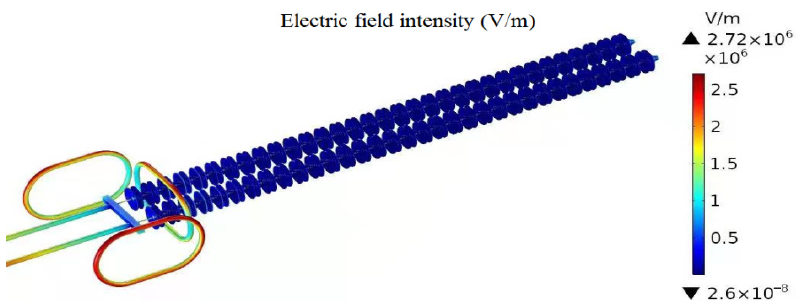
Figure 7. The electric field distribution of a tension insulator string grading ring and shielding rings.